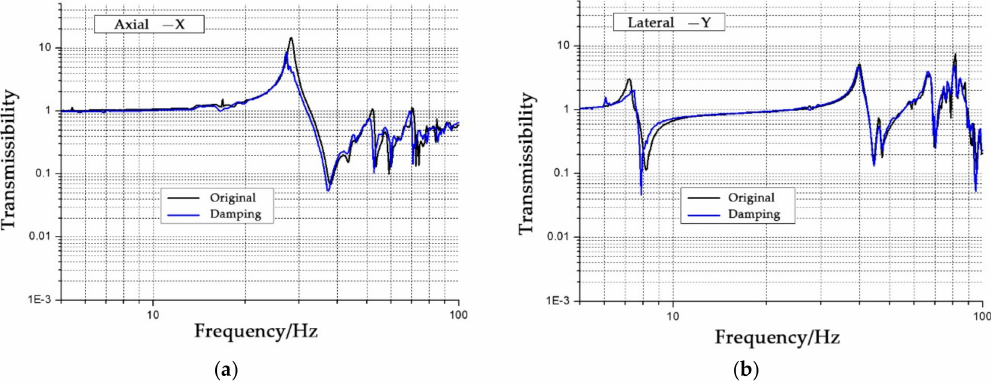
Figure 15. Frequency response analysis results: ( a ) axial-X; ( b ) lateral-Y.